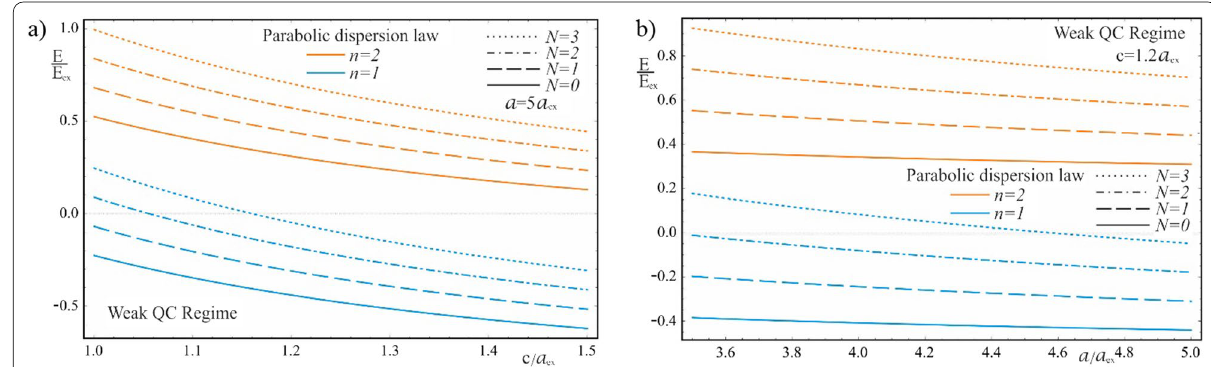
Fig. 8 The dependences of the exciton energy on ( a ) the minor semiaxis c at the fixed value of the major semiaxis a , ( b ) the major semiaxis a at the fixed value of the minor semiaxis c (parabolic dispersion